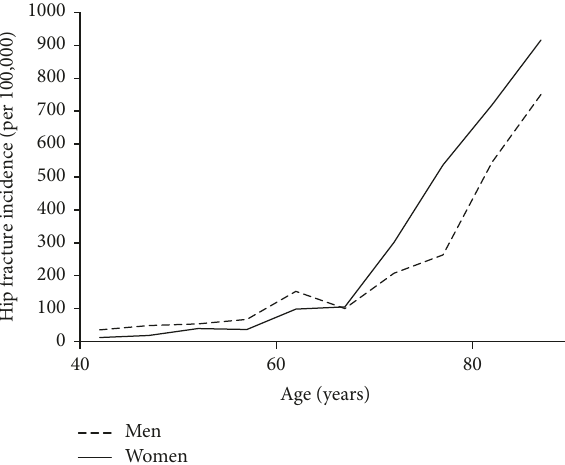
Figure 3: Hip fracture incidence in men and women aged 40 years and older in the Ukraine. Data are computed in 5-year age